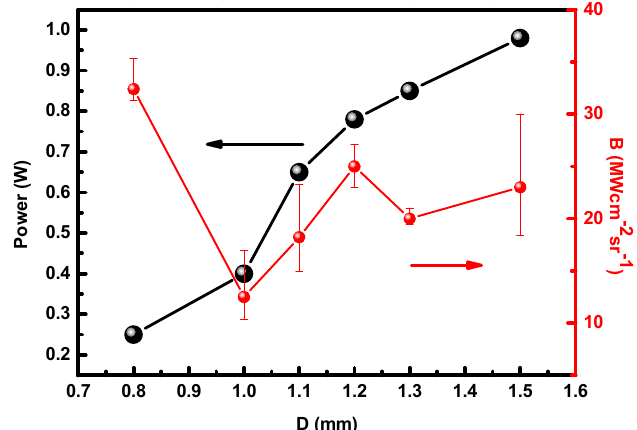
Figure 10. Dependences of output power and beam brightness on the aperture size D at 25 W input power.